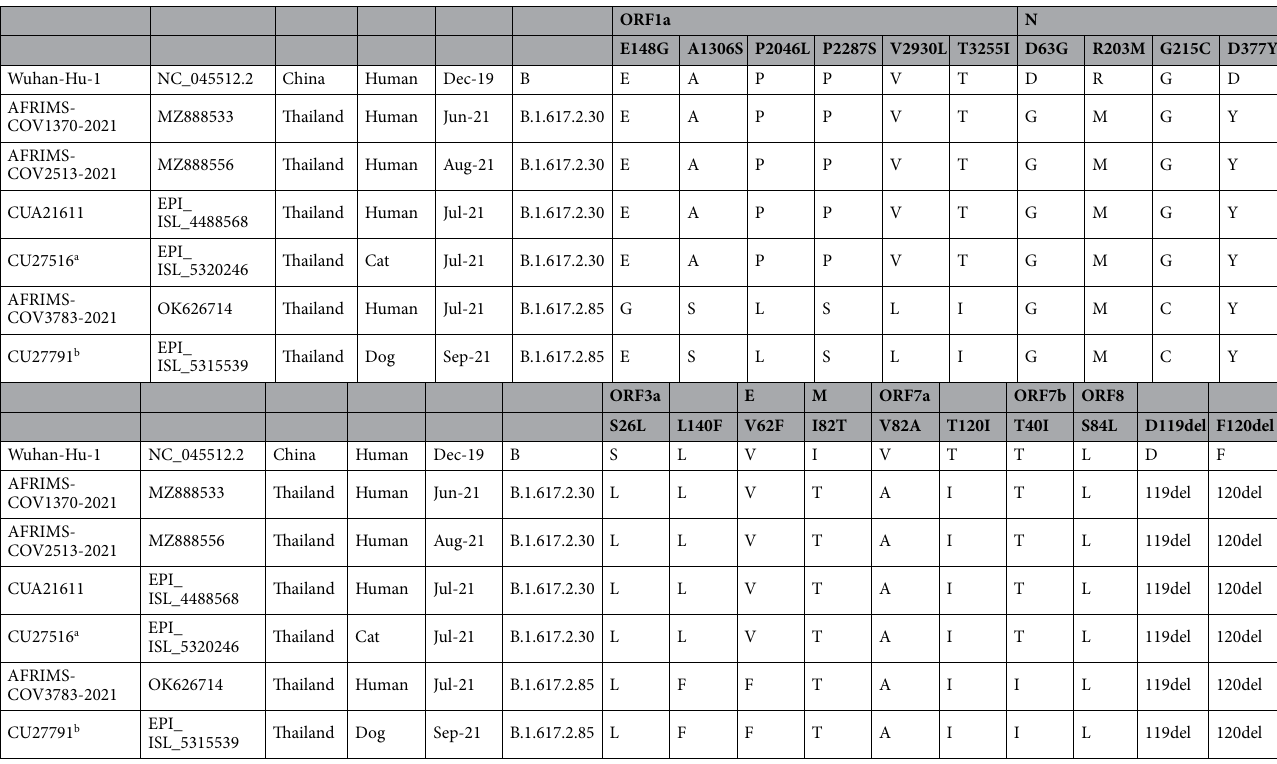
Table 5. Characteristic mutations of SARS-CoV-2 delta variant from cat (AY.30) and dog (AY.85) and reference viruses. a SARS-CoV-2 characterized in this study. b SARS-CoV-2 characterized in this